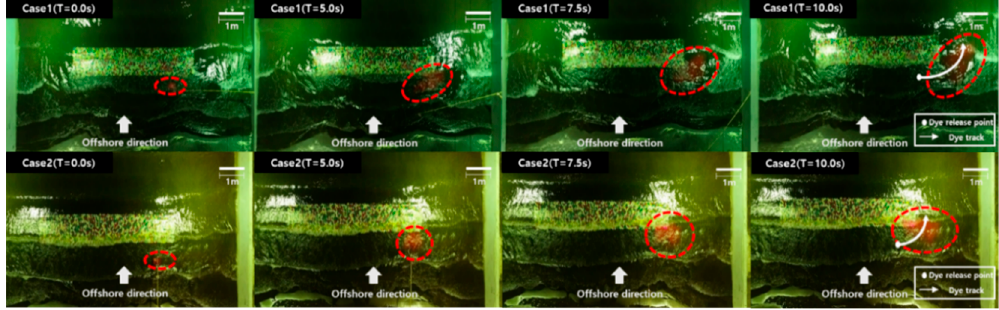
Figure 8. Flow patterns around the structure by structure type (Case 1: dolos; Case 2: hybrid (dolos with the coral reef)) determined using